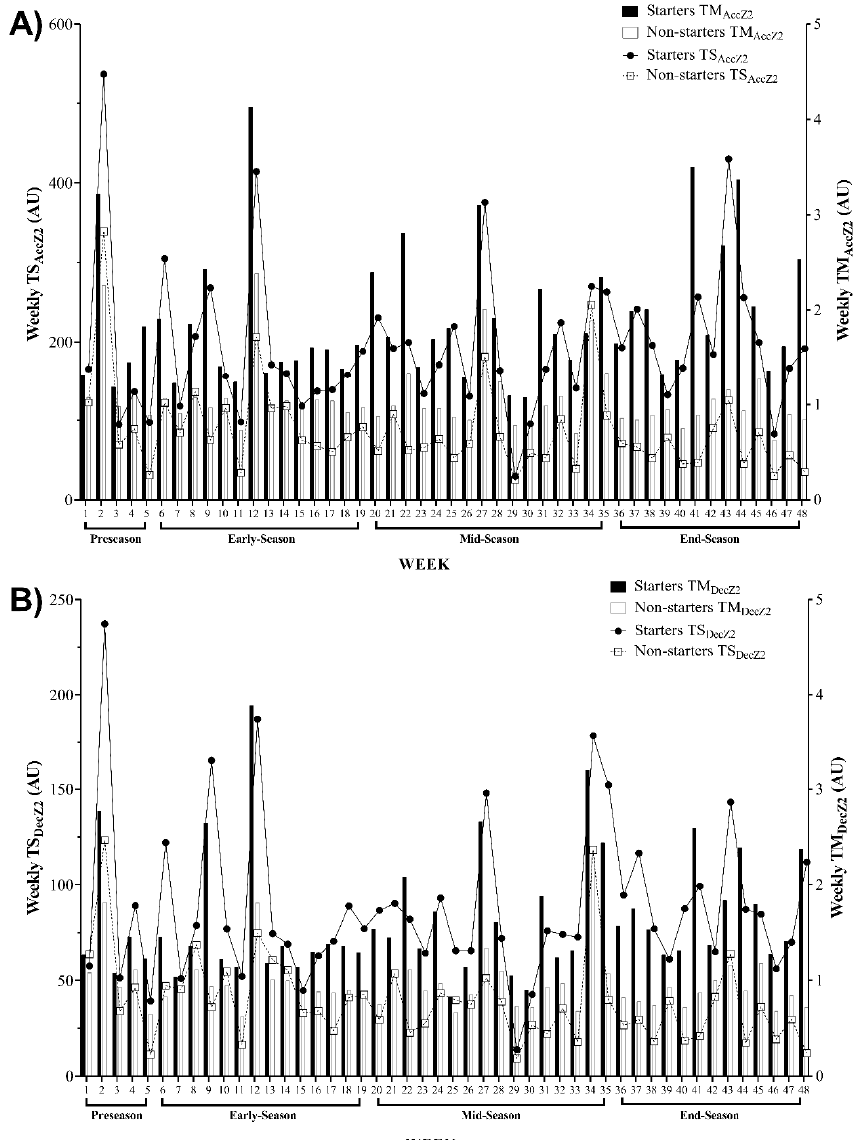
Figure 2. Descriptive statistics of weekly average for training monotony (TM) and training strain (TS) and their variations across the full season based on ( A ) number of accelerations in zone 2 (2 to 4 m·s − 2 ) and ( B ) number of decelerations in zone 2 ( − 2 to − 4 m·s − 2 ). AU, arbitrary units; TM AccZ2 , weekly training monotony based on number of accelerations in zone 2 (2 to 4 m·s − 2 ); TS AccZ2 , weekly training strain based on number of accelerations in zone 2 (2 to 4 m·s − 2 ); TM DecZ2 , weekly training monotony based on number of decelerations in zone 2 ( − 2 to − 4 m·s − 2 ); TS DecZ2 , weekly training strain based on number of decelerations in zone 2 ( − 2 to − 4 m·s − 2 ).